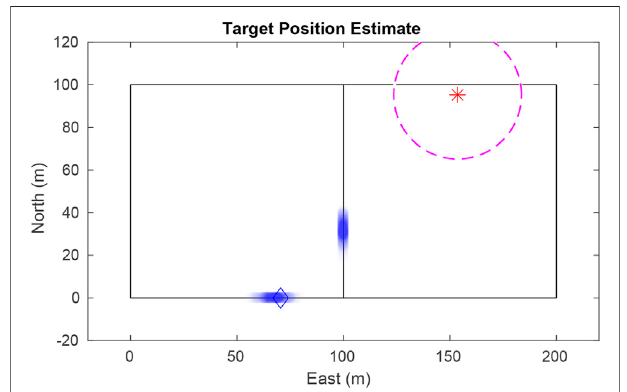
FIGURE 1 | The single-target particle fi lter maintains a fi nite number of hypotheses, even after the vehicle has traveled some distance since being seen. Particles are plotted as transparent dots to indicate density. The blue diamond shows true target position, the star shows the UAV position, and the dashed circle delineates the UAV ’ s fi